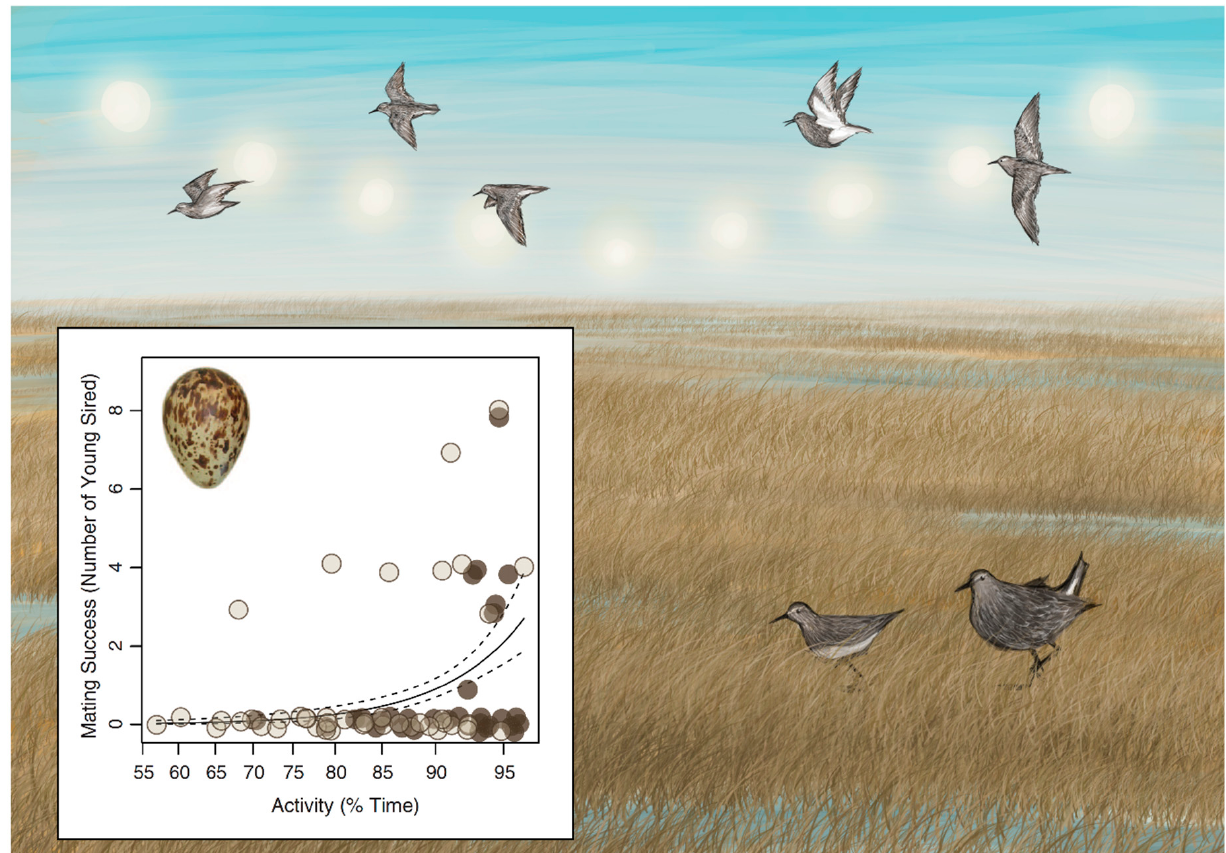
Figure 4. The sun never sets during summer in the high Arctic. In this environment, some male pectoral sandpipers sleep little and are extremely active during the three-week breeding season. Although there was substantial male–male variation in the level of activity, males that slept the least ultimately sired the most offspring (inset from Lesku et al. [6]). Illustrations by Laura X. Tan.